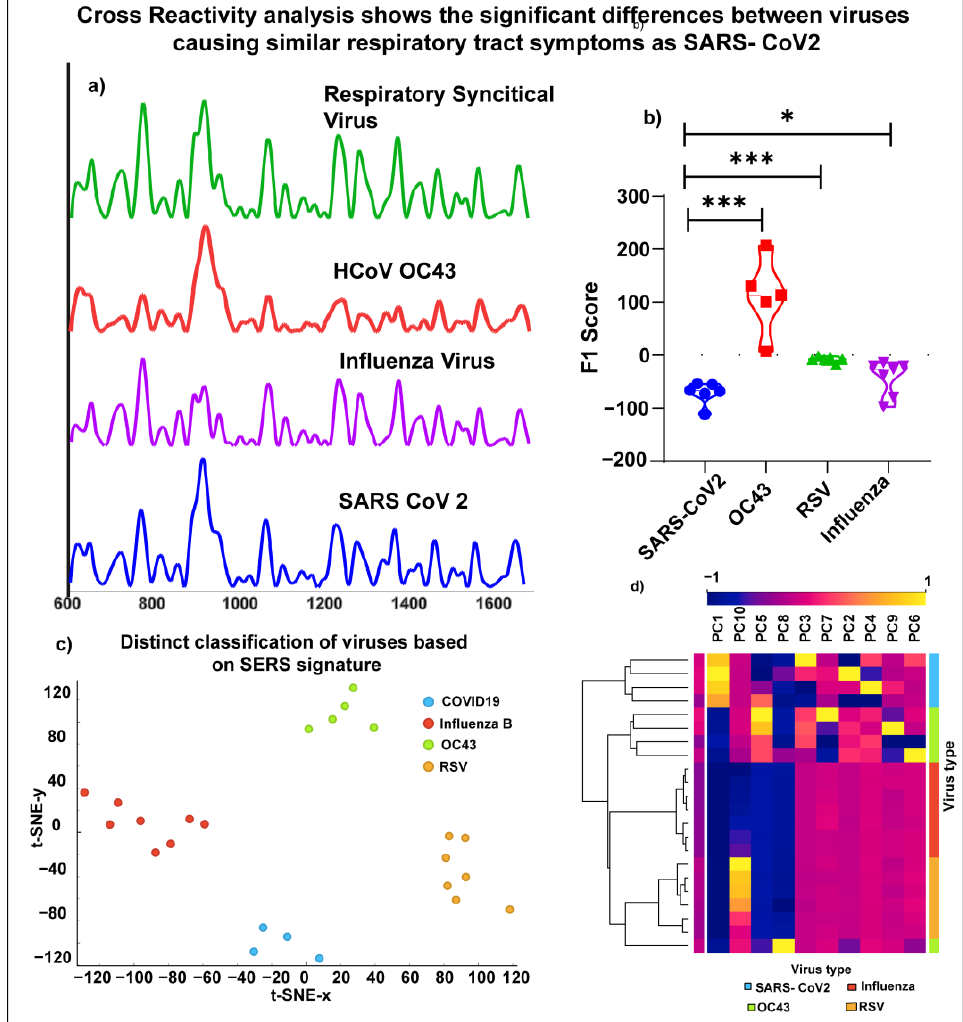
Figure 5. Cross-reactivity analysis shows the ability of the nanostructured sensor to distinguish different viruses clearly ( a ) Representative SERS spectra of SARS-CoV-2, Influenza, HCoV OC43, Respiratory syncytial virus, ( b ) Violin plot showing the F1 scores using partial least square method ( c ) tSNE analysis showing the clear distinction between different viral species, showing the high specificity of the label-free SERS saliva test using a nanostructured sensor ( d ) Heatmap showing the significant principal component contributing to the high specificity of the label-free SERS saliva test using the nanostructured sensor.(*—( p -value < 0.01), ***—( p -value < 0.0001)).